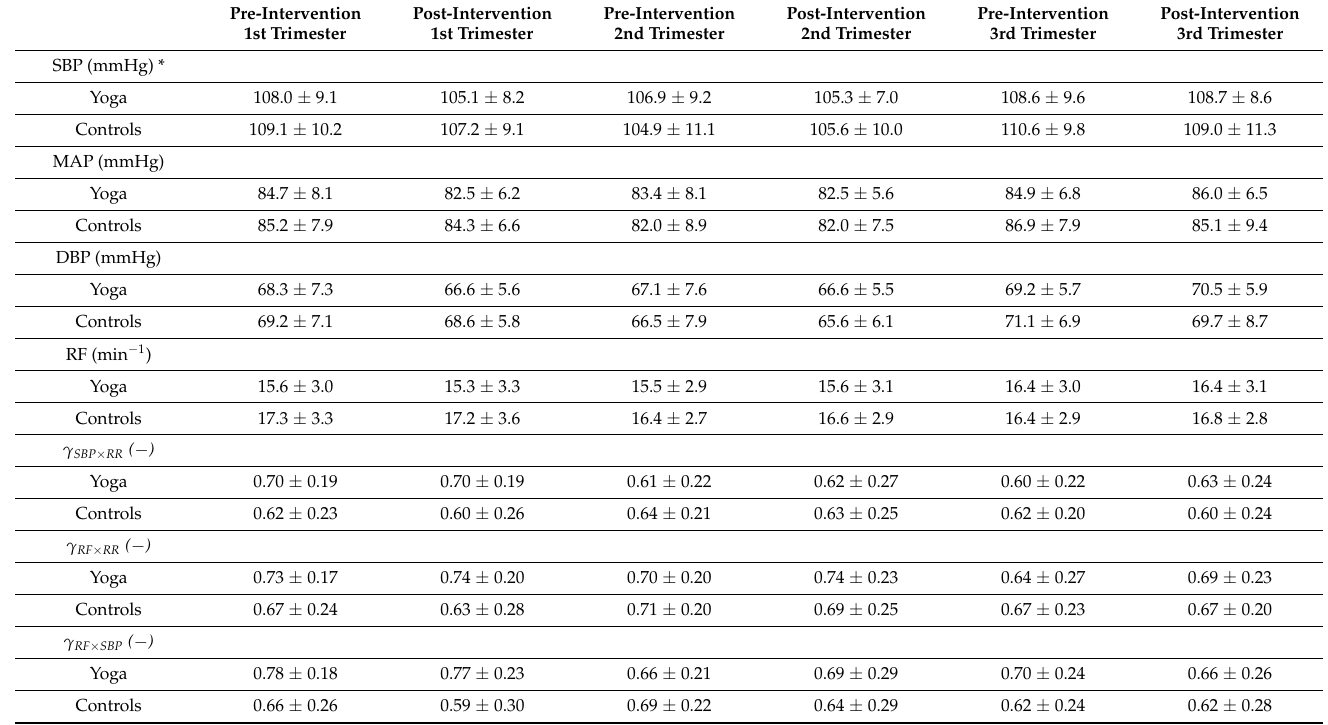
Intervention in the yoga group consisted of 90 min prenatal yoga practice; intervention in the control group consisted of 30 min walk; SBP systolic blood pressure; MAP mean arterial pressure; DBP diastolic blood pressure; RF respiratory frequency; γ SBP × RR synchronization index between systolic blood pressure and RR interval (inter- beat interval between all successive heartbeats); γ RF × RR synchronization index between respiratory frequency and RR interval; γ RF × SBP synchronization index between respiratory frequency and systolic blood pressure, * represent statistically significant differences following yoga vs. controls in all three